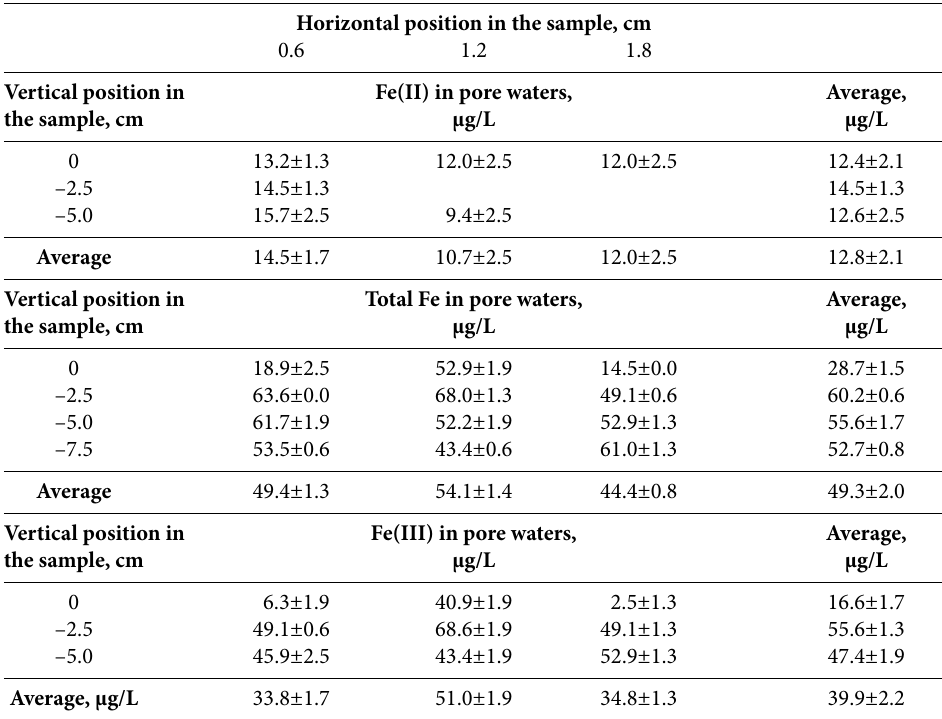
Table 4. Concentrations of the Fe redox species in the Vrtojbica